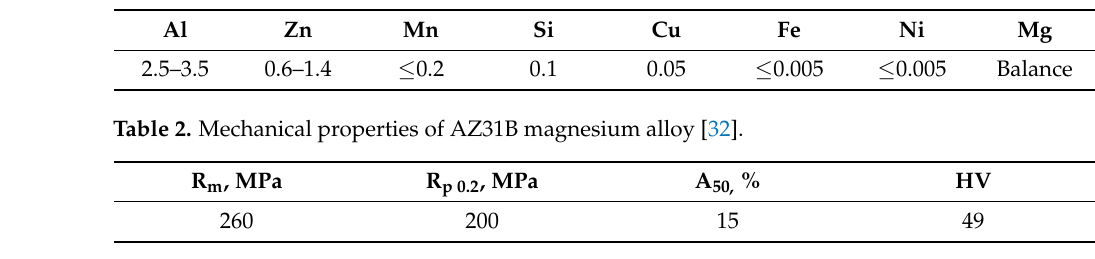
Table 1. Chemical composition of AZ31B magnesium alloy (in wt. %) [32].